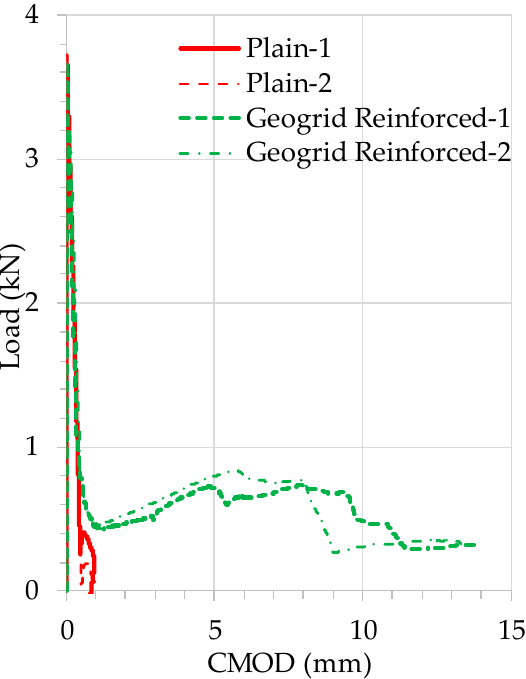
Figure 7. Load-CMOD behavior.